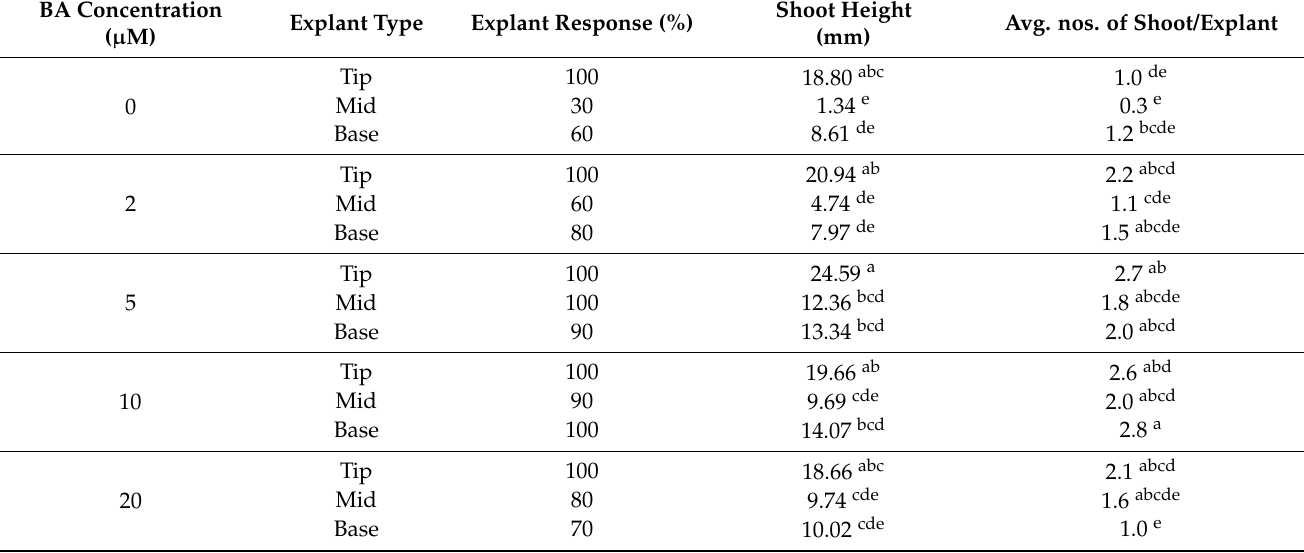
Table 1. Effect of BA (0–20 µ M) added to the culture medium and the explant type on explant response, average shoot number, and shoot height. Data represents mean from three replications and 10 explants per replication. Means marked by different letters in columns are significantly different according to the Tukey test ( p <